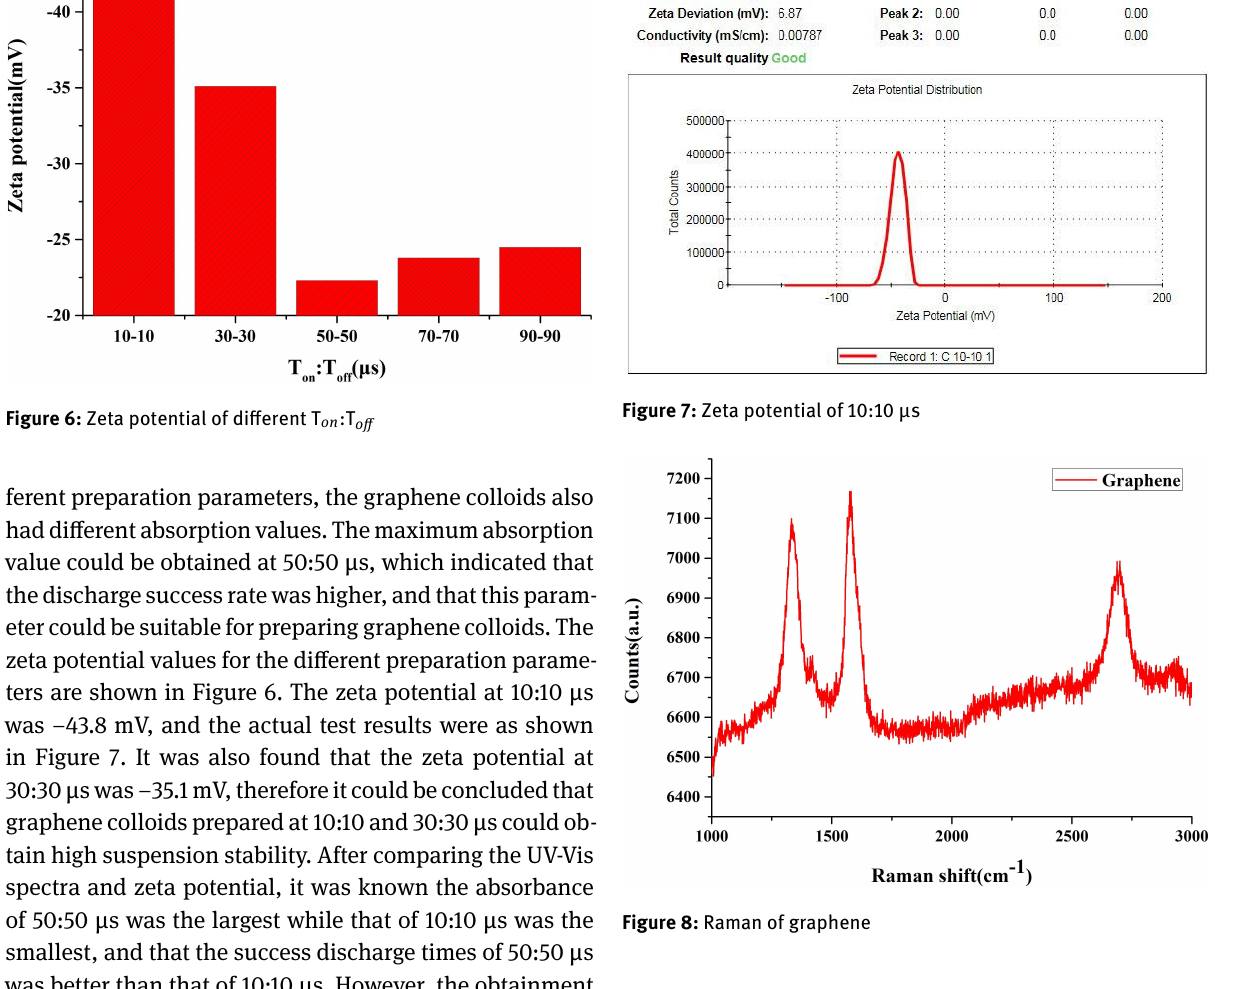
Figure 8: Raman of graphene fects of graphene. The G-band was the main characteristic peak of graphene at 1579 cm −1 , which was caused by the structural vibration of the sp 2 carbon atom. The 2D-band was a second-order Raman peak of two-phonon resonance at 2700 cm −1 , which was used to represent the interlayer stacking mode of carbon atoms in graphene. The TEM im- ages are shown in Figure 9. From Figure 9(a) and (b), it could be clearly seen that the thickness of the graphene sheets was smaller in the shallower areas and larger in the darker areas. Figure 9(c) shows the existence of lat- tice lines, which represented the interlayer distance of the graphene sheets. The distance was 0.35